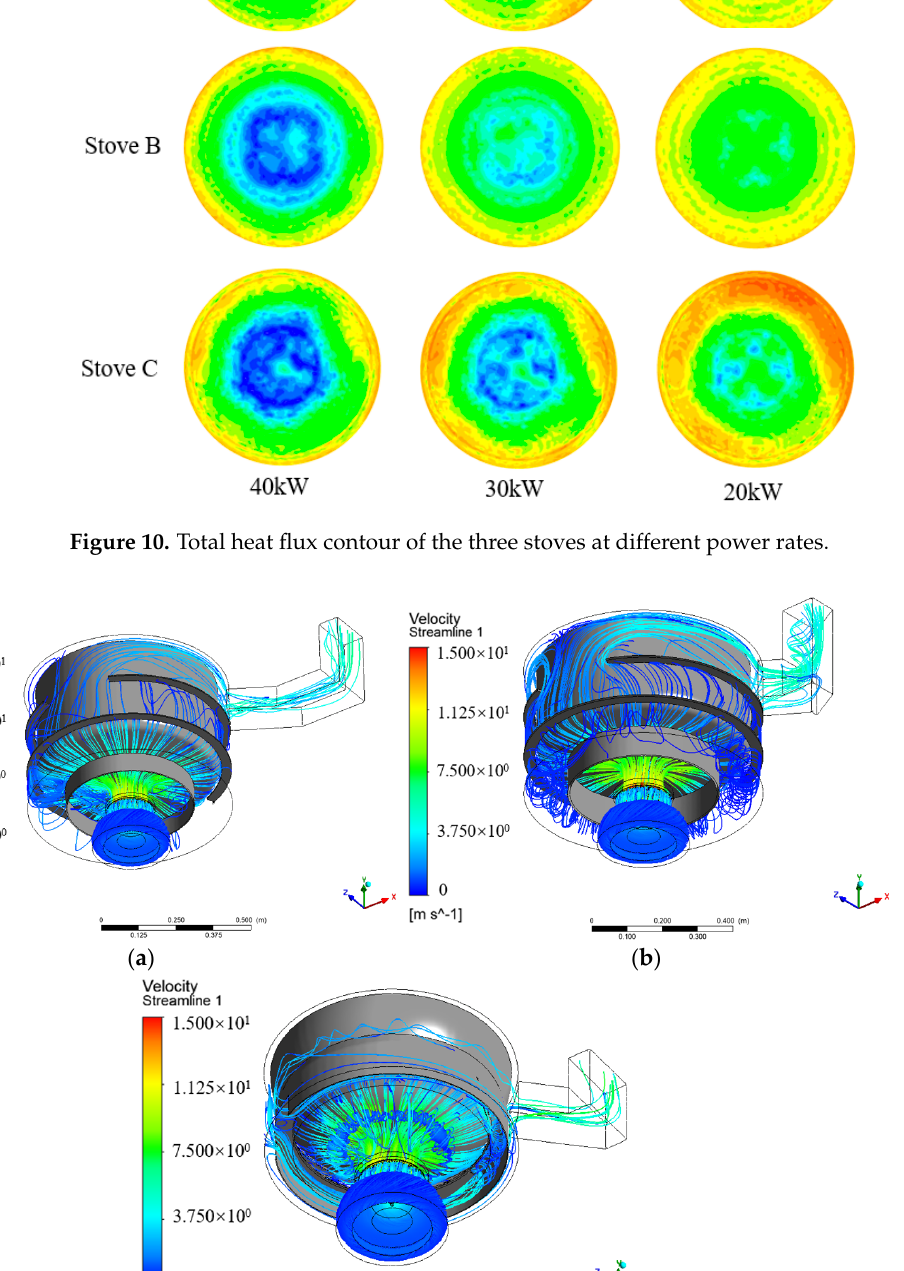
Figure 11. Streamline of the three stoves at 40 kW: ( a ) staple food stove A; ( b ) staple food stove B, ( c ) subsidiary food stove C. The CO mass fraction (flue outlet) of the three stoves at different power levels is shown in Figure 12. Comprehensively, the CO emissions of the stoves decrease with a decrease in power. The CO emissions of stove B significantly surpassed that of other as- sembled stoves over different power levels, this is because the space composed of the fire- board, and the vessel is near the closure, which is not conducive to the full combustion of fuel.